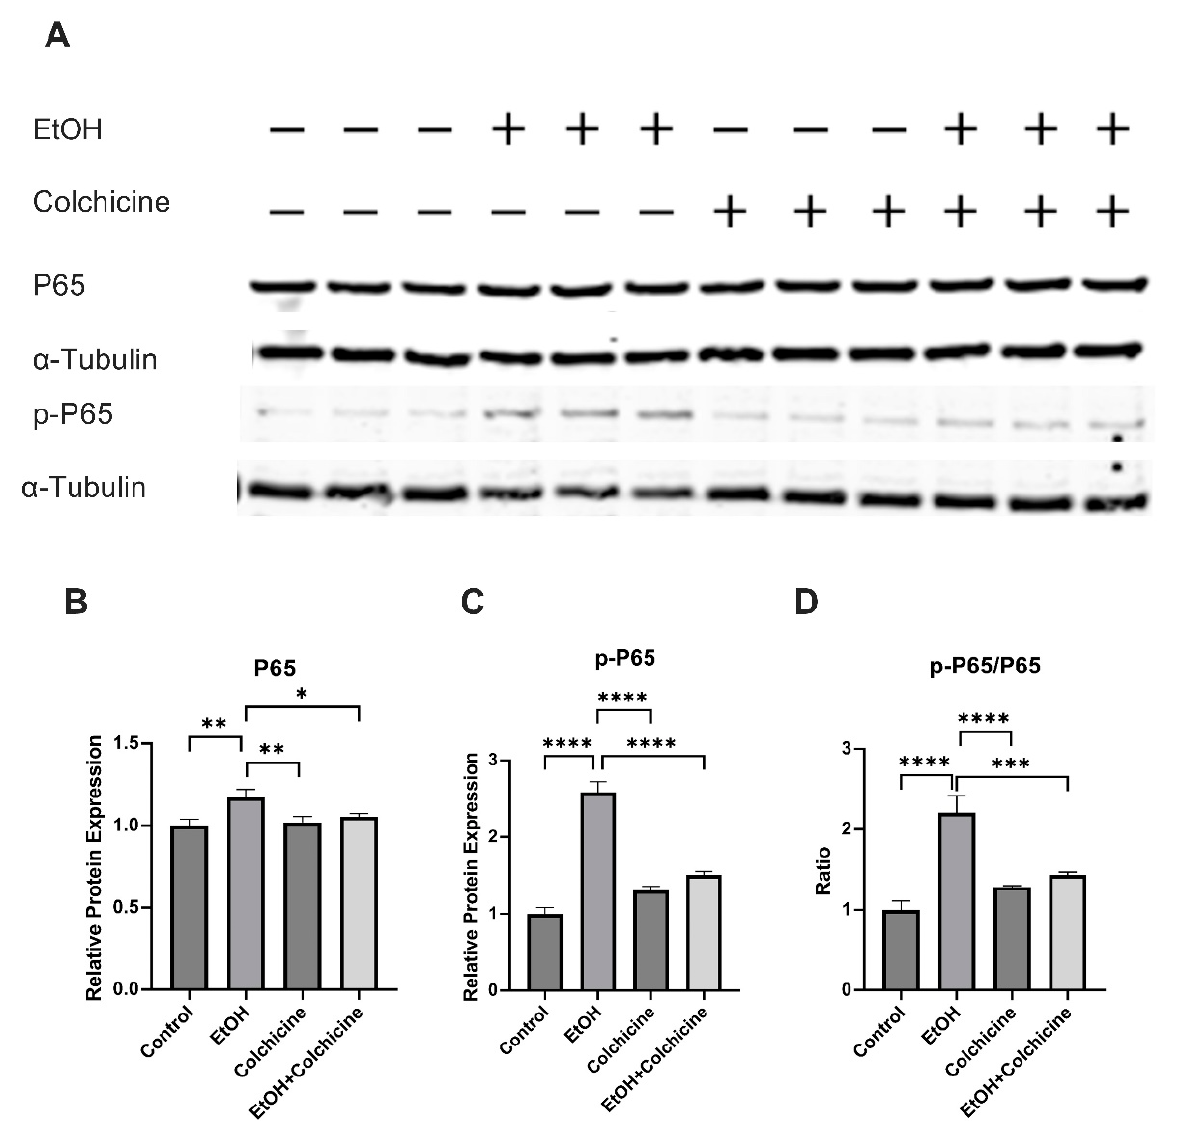
Figure 3. Colchicine inhibited nuclear factor kappa B (NF- κ B) activation: ( A ) Western blots for proteins of P65 and p-P65. Colchicine obviated the relative protein expression of ( B ) P65 and ( C ) p-P65 in ethanol-treated endothelial cells. ( D ) The ratio of p-P65/P65 was significantly decreased in ethanol-treated endothelial cells exposed to colchicine. α -Tubulin was used as loading control. Biological triplicates were used for the experiment. Data was analyzed by performing one-way ANOVA followed by Tukey’s test. Error bars represent the SD (**** p < 0.0001, *** p < 0.001, ** p < 0.01, and * p < 0.05).